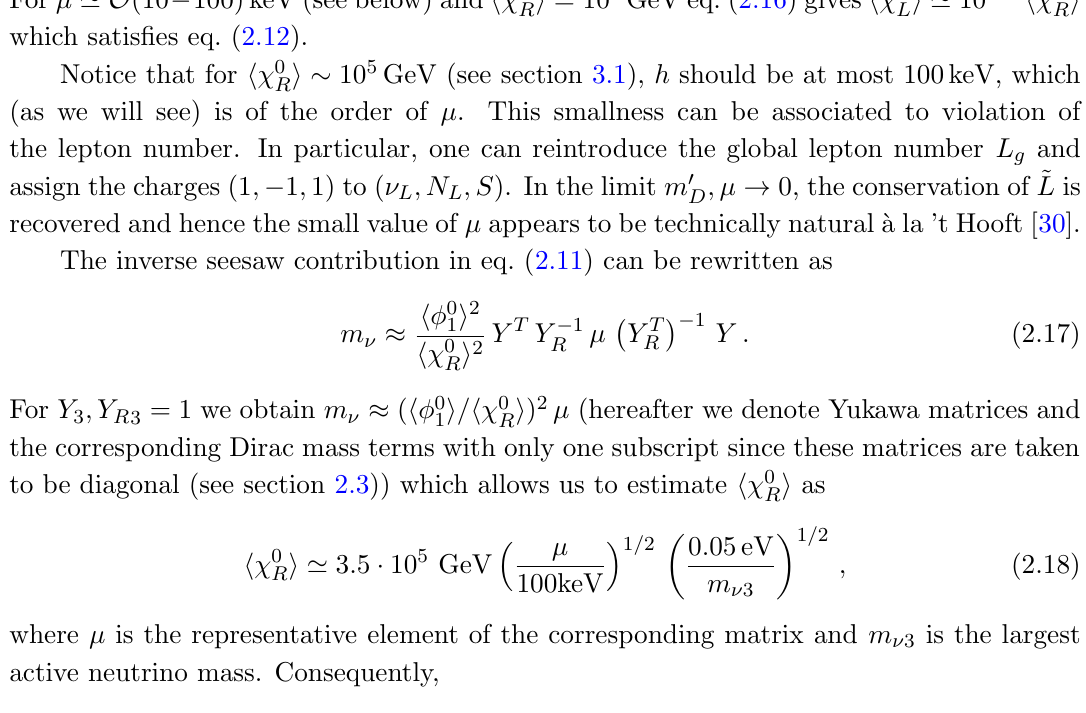
(cid:8) (cid:31) R term in the L